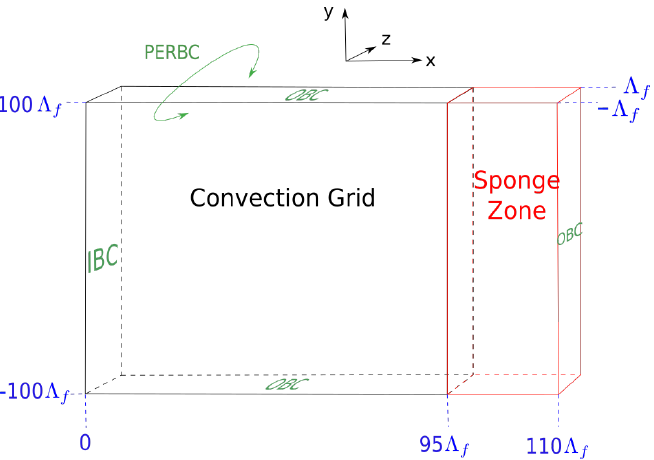
Figure 4. Schematic of the Single Grid configuration. IBC stands for inflow boundary condition, OBC for outflow boundary condition and PERBC for periodic boundary